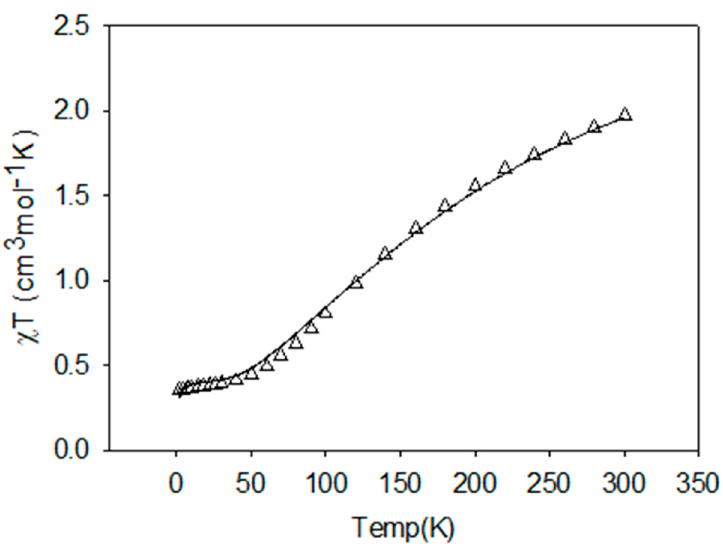
Figure 14. Plots of χ M T (triangles) vs. T per mole of [Cu 2 ] unit for 5 . The solid line is the best fit to the experimental